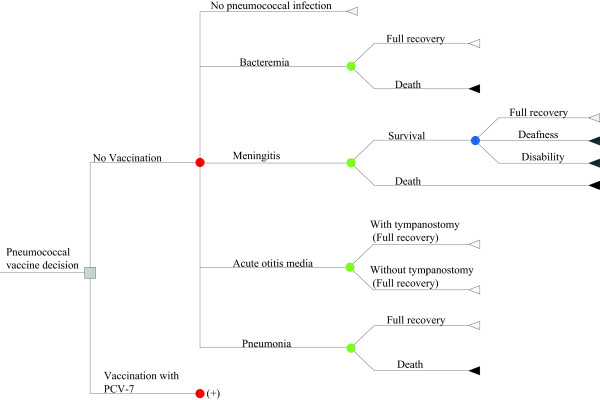
The structure of the model, illustrating the two alternatives for PCV vaccination (including no vaccine) and possible subsequent events for each child. The following health states are included: meningitis, bacteremia, pneumonia, AOM and no infection.